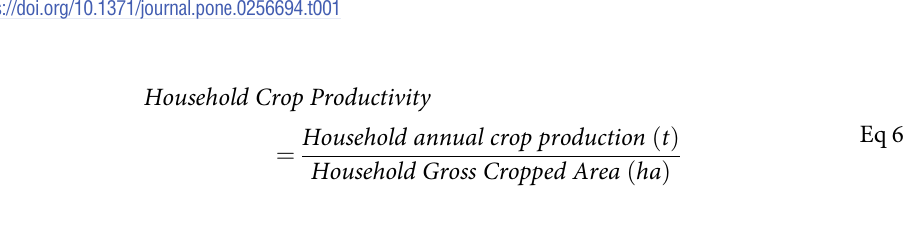
1 Variables represent socioeconomic status, field characteristics, and crop management practices in polder and non- polder households of south-central coastal Bangladesh during the study period